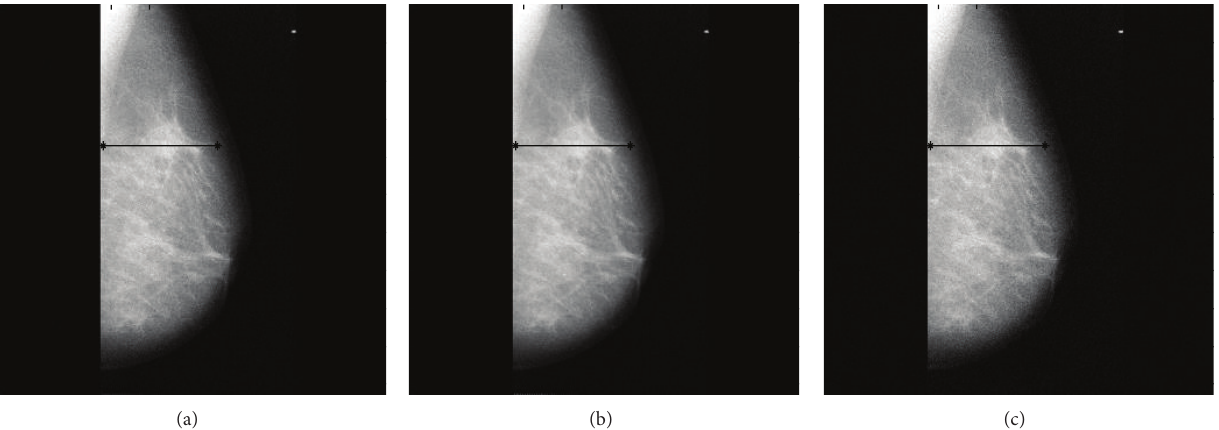
Figure 3: Image processing results for mammograms. (a) Image processed by the proposed method, (b) image processed by the modified UDWT method, and (c) image processed by the sigmoid-type wavelet coefficient mapping